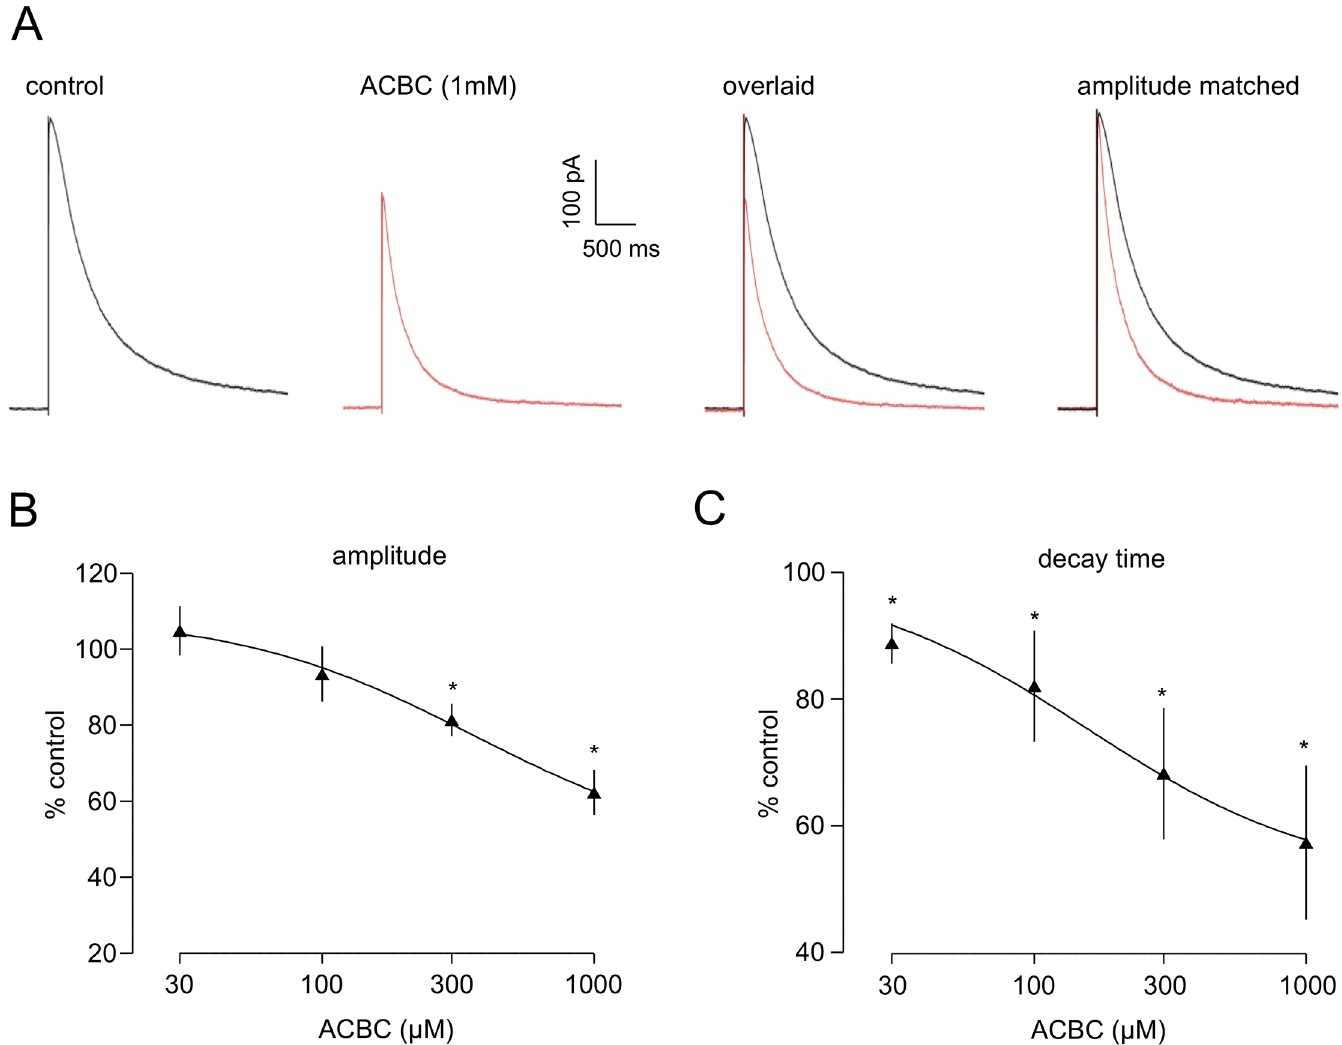
Fig 7. ACBC reduces preNMDAr activity. A. The histogram shows normalised frequency data for 5 neurones and indicates a significant decrease in frequency in the presence of the low-efficacy partial agonist. B. There was no concurrent change in frequency distribution of event amplitudes. C. The averaged mEPSCs recorded in one neurone illustrate that peak amplitude, rise and decay times of events was unaltered by ACBC. * P <